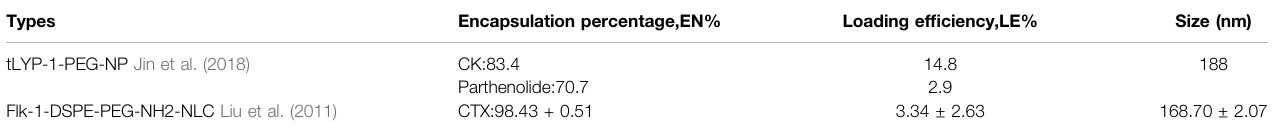
TABLE 3 | VEGFR antibody for active targeting of nanoparticle drug delivery